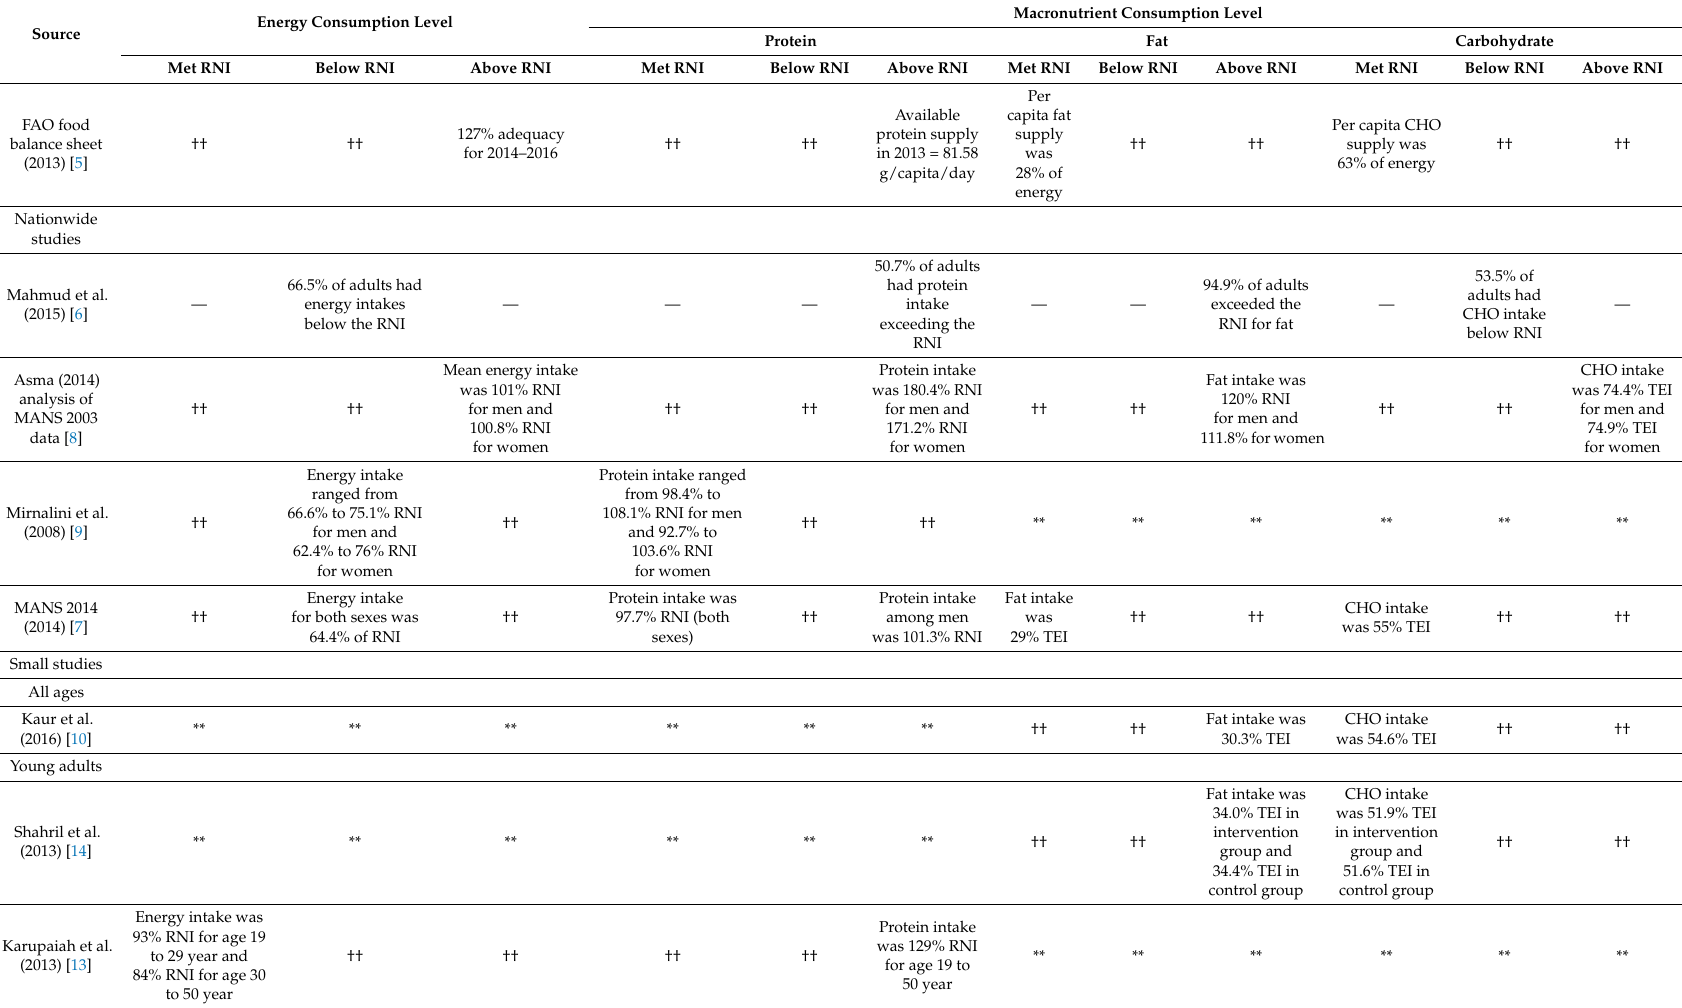
Table 2. Summary of study results regarding adherence of Malaysian adults’ energy and macronutrient intakes to national